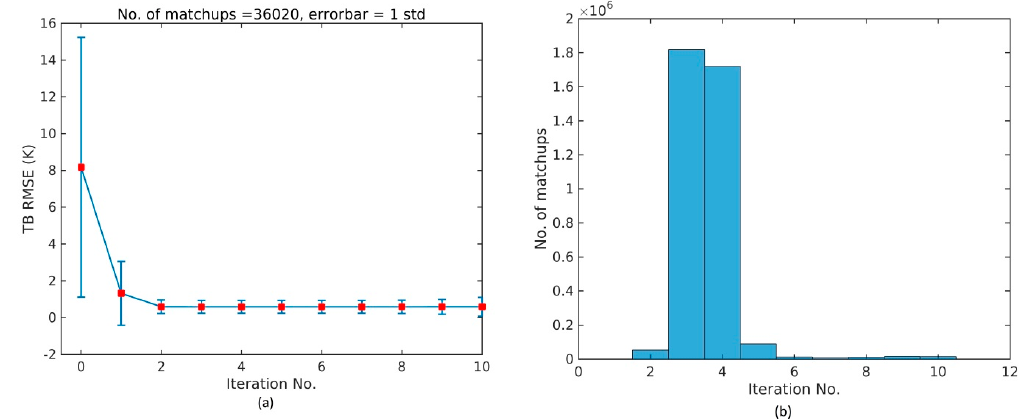
Figure 4. ( a ) The mean RMSE TB for all channels is plotted for each iteration number. Uncertainty bars show one standard deviation; ( b ) number of iterations performed for all drifter matchups during 2010.